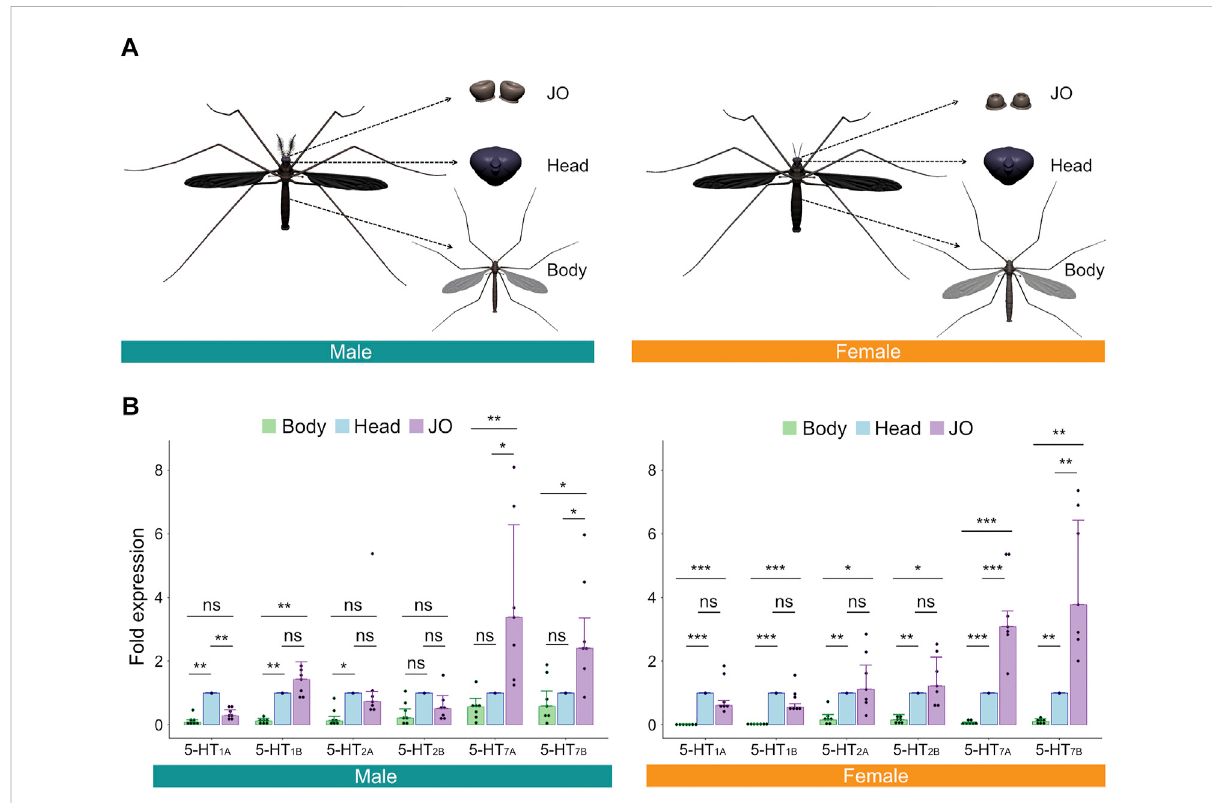
FIGURE 2 Serotonin receptors are expressed in male and female Ae. aegypti JOs. (A) Diagrams of tissues dissected and tested via RT-qPCR. (B) Fold expression of each of the six serotonin receptors in male (left) and female (right) bodies, heads, and JOs. Seven repeats were conducted for each tissueinbothsexes.ThebargraphshowsthemedianwithanSEMerrorbar.Eachdotrepresentsthefoldexpressionofeachrepeat.Foldexpressions of body (green) and JO (purple) were normalized by that of the head (blue). ns, p > 0.05; *, p ≤ 0.05; **, p ≤ 0.01; ***, p ≤